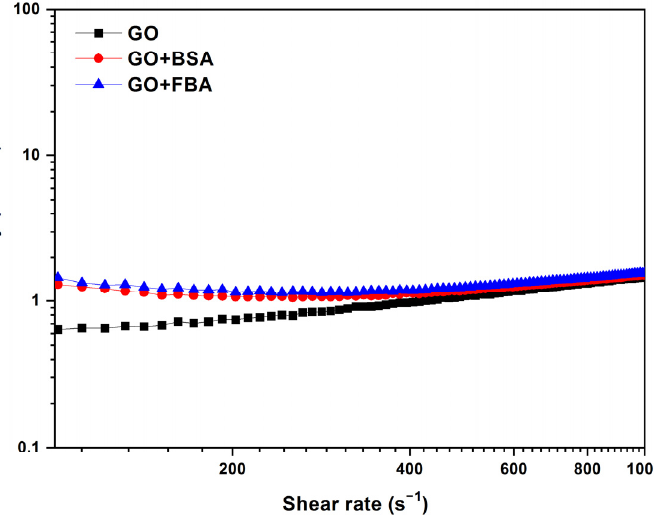
Figure 7. Viscosity ( η ) vs. shear rate ( γ(cid:4662) ) of GO, GO + BSA, and GO + FBS (GO = 0.25 mg/mL; BSA = 0.02 mg/mL and FBS = 0.2 mg/mL). Temperature: 37 °C.